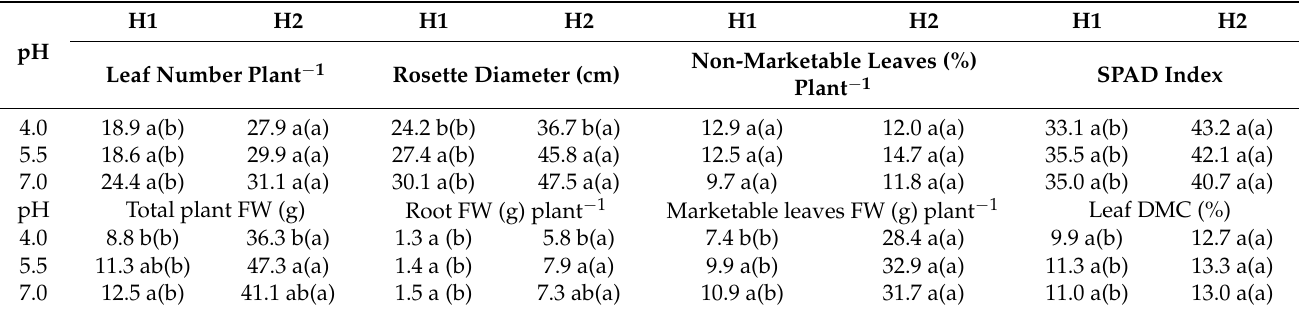
Table 1. Growth parameters of Taraxacum officinale plants grown under different nutrient solution pH, harvested at H1 (16-DAST) and H2 (29-DAST: Days after the Start of pH Treatment).